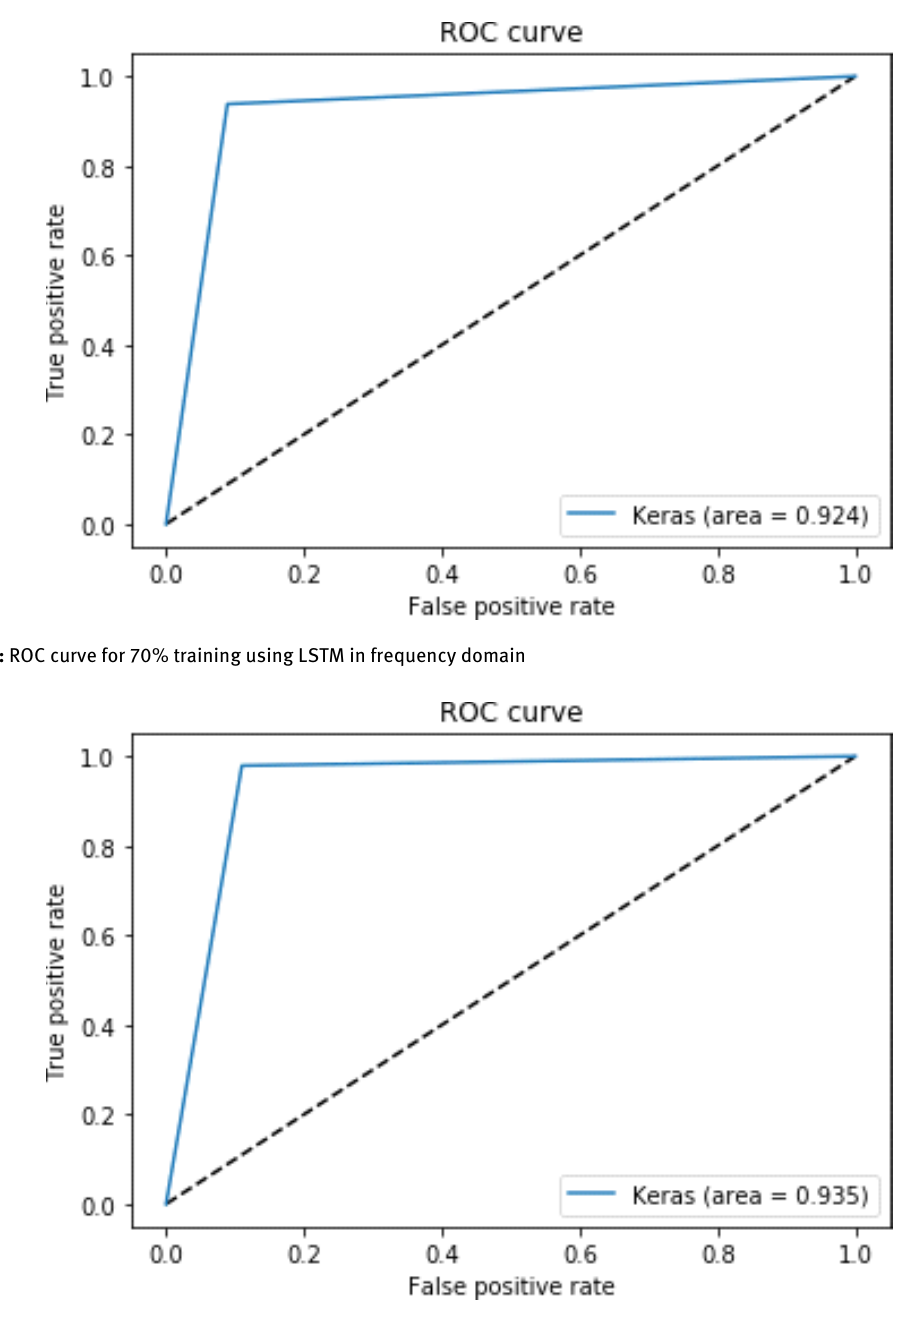
Figure 13: ROC curve for 80% training using LSTM in frequency